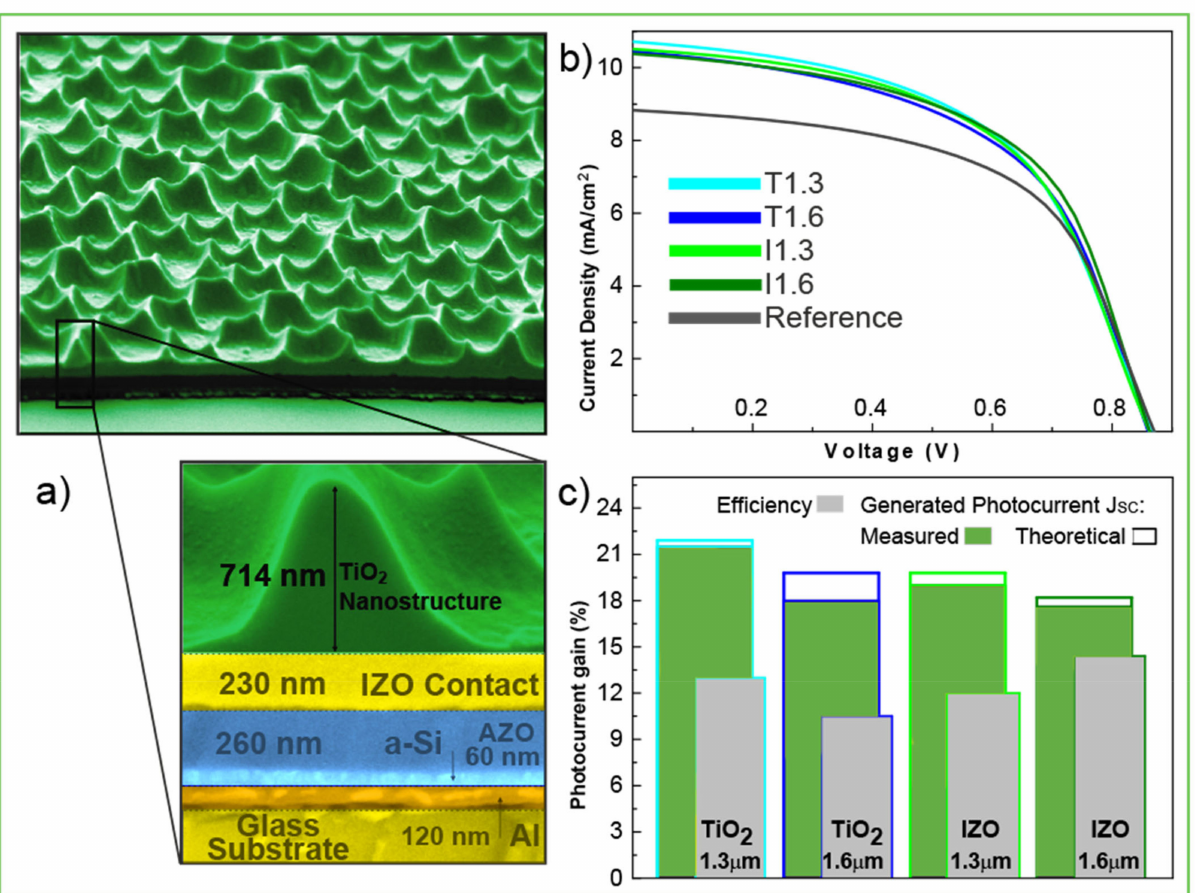
Figure 12. ( a ) SEM images of the cross-section of an a-Si:H solar cell coated with a TiO 2 -based LT structure (patterned by CL) over its front flat IZO contact; ( b ) Measured J-V curves of solar cells incorporating four different photonic coatings made of either TiO 2 or IZO and formed with either 1.3 or 1.6 µ m diameter PS spheres, and compared with the curve of the planar reference cell with no LT structure over the IZO contact; ( c ) measured and theoretically modeled enhancement, relative to the reference, of the generated current density (dark grey and empty bars, respectively), and the measured conversion efficiency (light grey bars) of the devices in ( b ). Adapted with permission from [48]. Copyright 2021 The Royal Society of